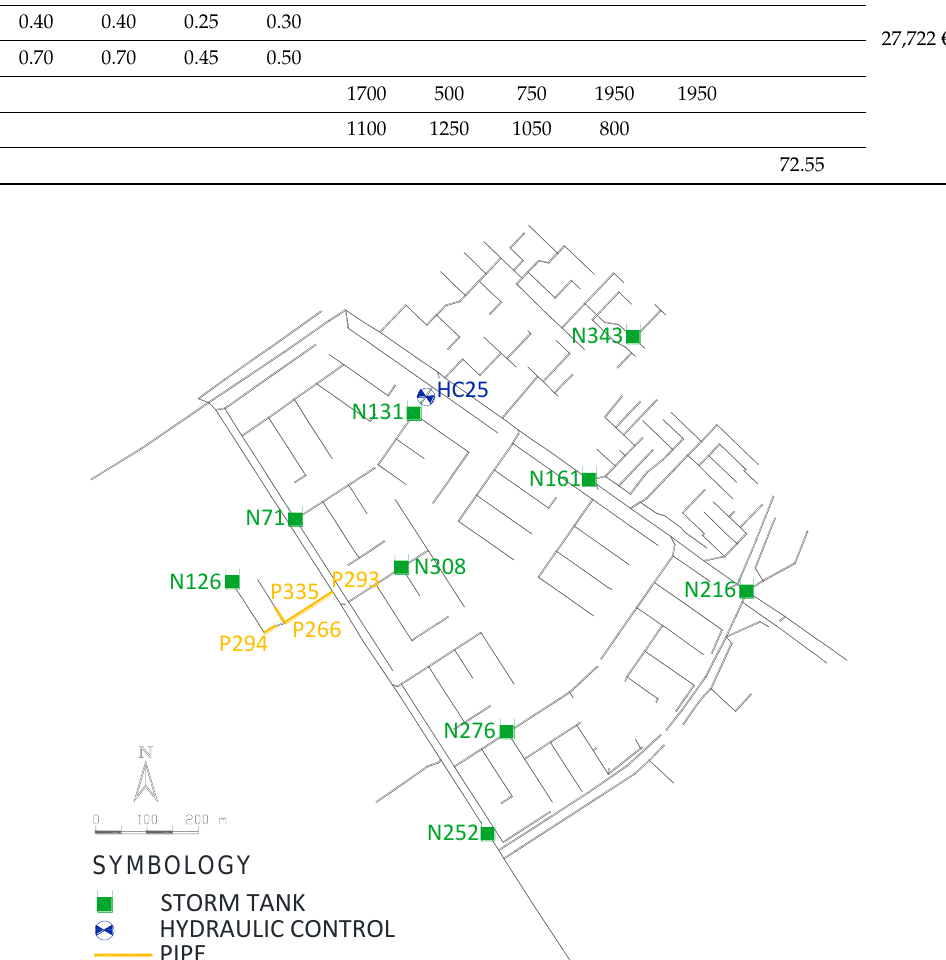
Figure 14. Location of infrastructure needed to rehabilitate the network. Table 4. Objective function of the best solution found for the ES-N network.